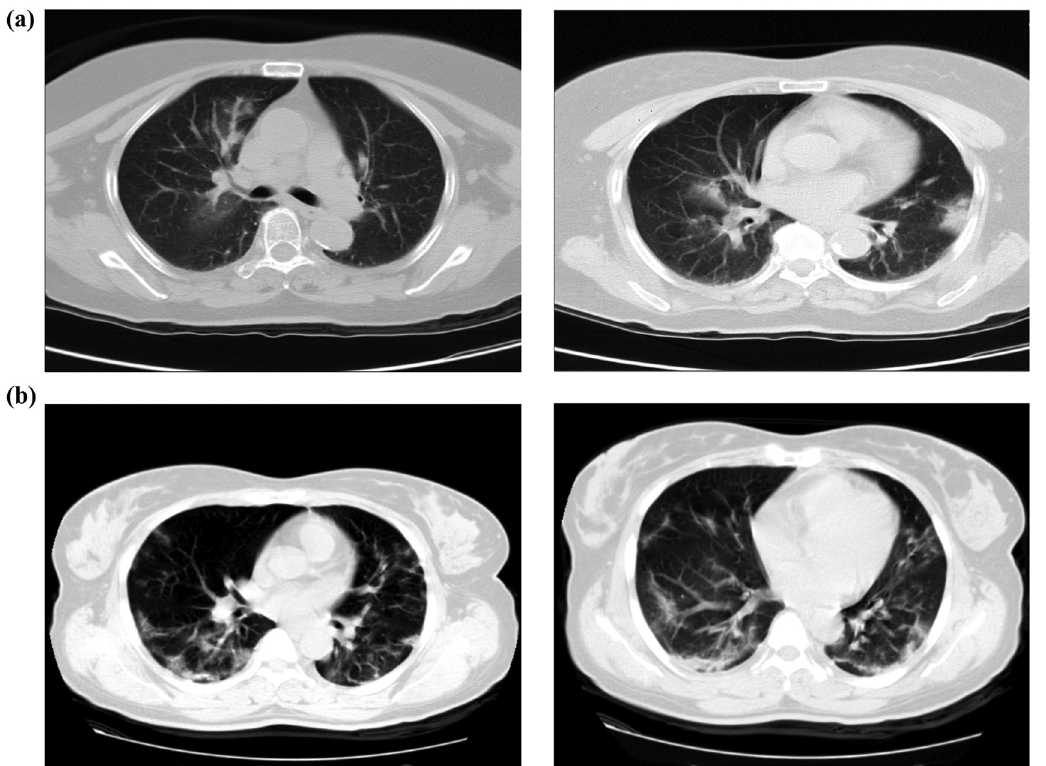
Figure 2: Chest - computed X - ray tomography ( CT ) images of two patients with COVID - 19. ( a ) Chest CT images of patients in the mildly ill group. ( b ) Chest CT images of patients in the severely ill